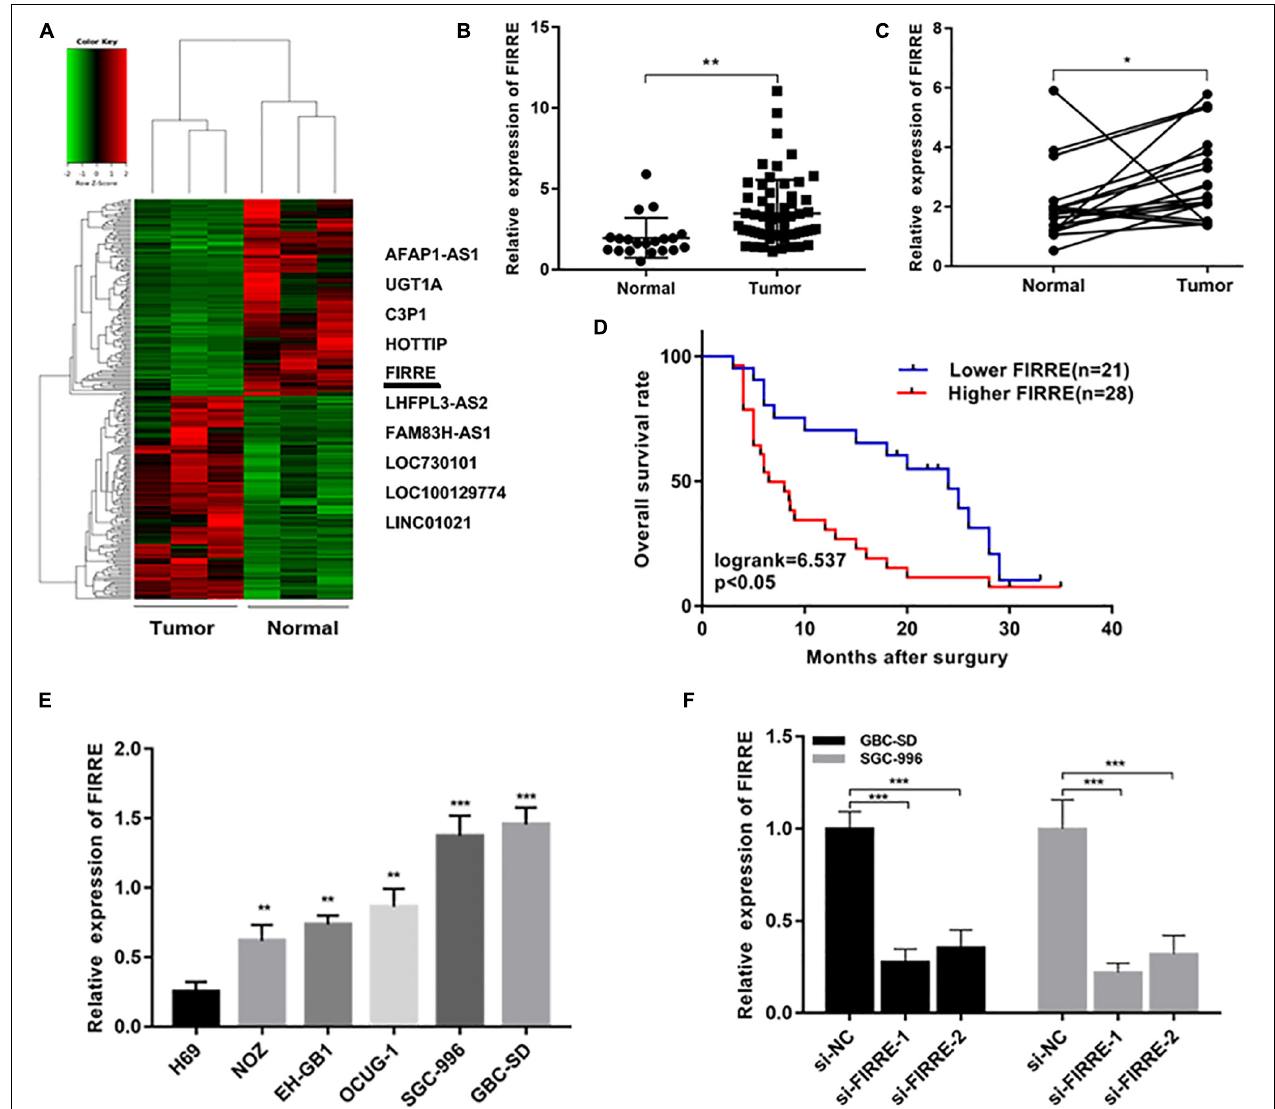
FIGURE 1 | Relative expression of FIRRE in GBC tissues, cells, and its clinical significance. (A) The cluster heat map showed the differentially expressed lncRNAs in GBC tissues and adjacent non-tumor tissues. The top 10 upregulated lncRNAs were listed. (B) Relative expression of FIRRE in GBC tissues ( n = 60) and non-tumor tissues ( n = 20) was examined by qRT-PCR assays. (C) FIRRE expression levels in GBC tissues and paired neighboring non-tumor tissues ( n = 20). (D) Kaplan–Meier analysis of overall survival according to FIRRE expression levels. (E) Relative expression of FIRRE in GBC cell lines and human biliary epithelium cell line H69. (F) Relative expression of FIRRE in GBC-SD cells and SGC-996 cells transfected with siRNAs. * p < 0.05, ** p < 0.01, *** p < 0.001.